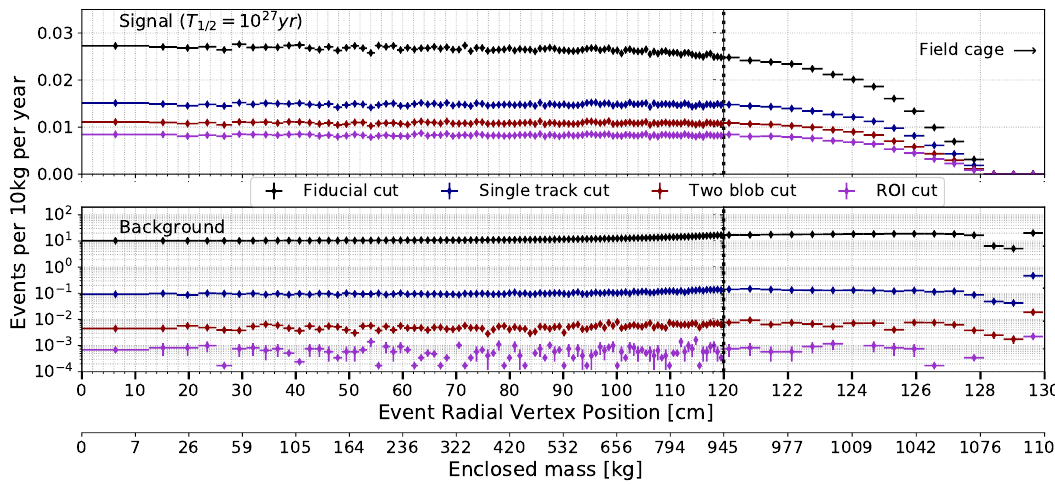
Figure 11 . Event rate normalized by mass as a function of the vertex radial position in the detector for signal ( 0 νββ events) and background ( 208 Tl and 214 Bi decays). In the case of signal events, the vertex corresponds to the emission point of the two electrons, while for background events it indicates the interaction point of the high-energy background gamma entering the detector. The drop in signal rate in the last 10 cm is an effect of considering only fully contained events and that the approximate span of 0 νββ events at the density considered is 10 cm